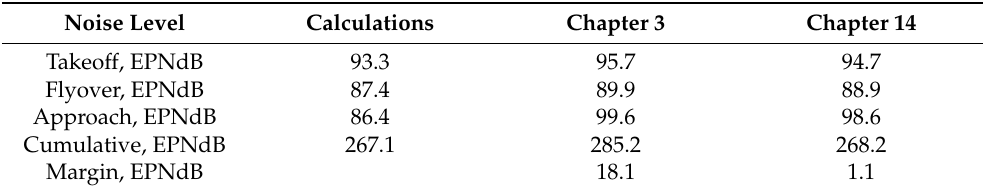
Table 4. Results of noise levels calculations for the next-generation supersonic civil